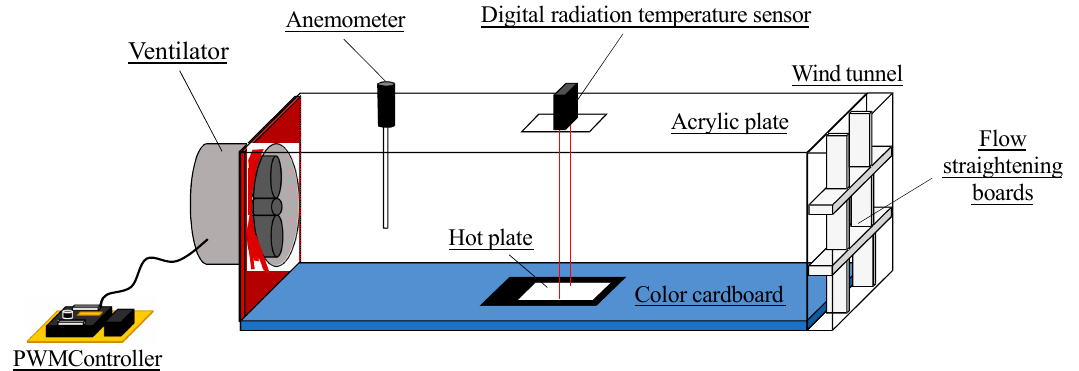
Figure 8. Sketch of the custom-built apparatus.